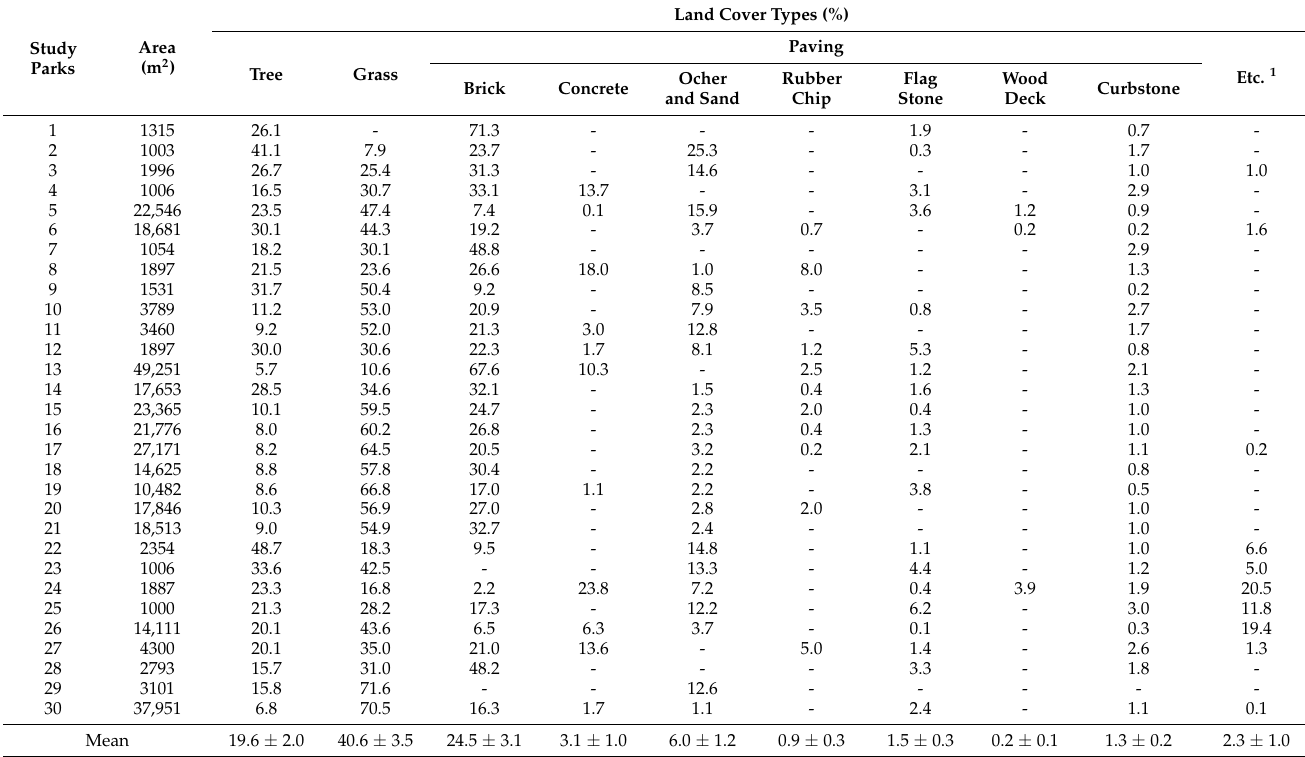
Table 4. The ratio of land cover types in study parks.